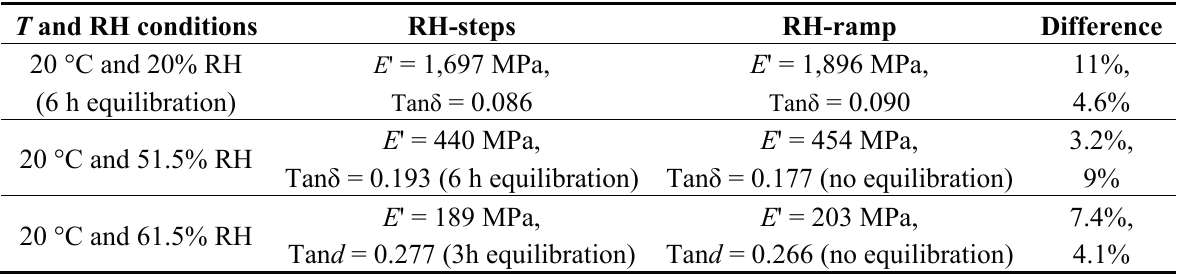
Table 4. Comparison of values of E ' and Tan δ obtained with the RH-ramp and RH-step methods of Figures 7 and